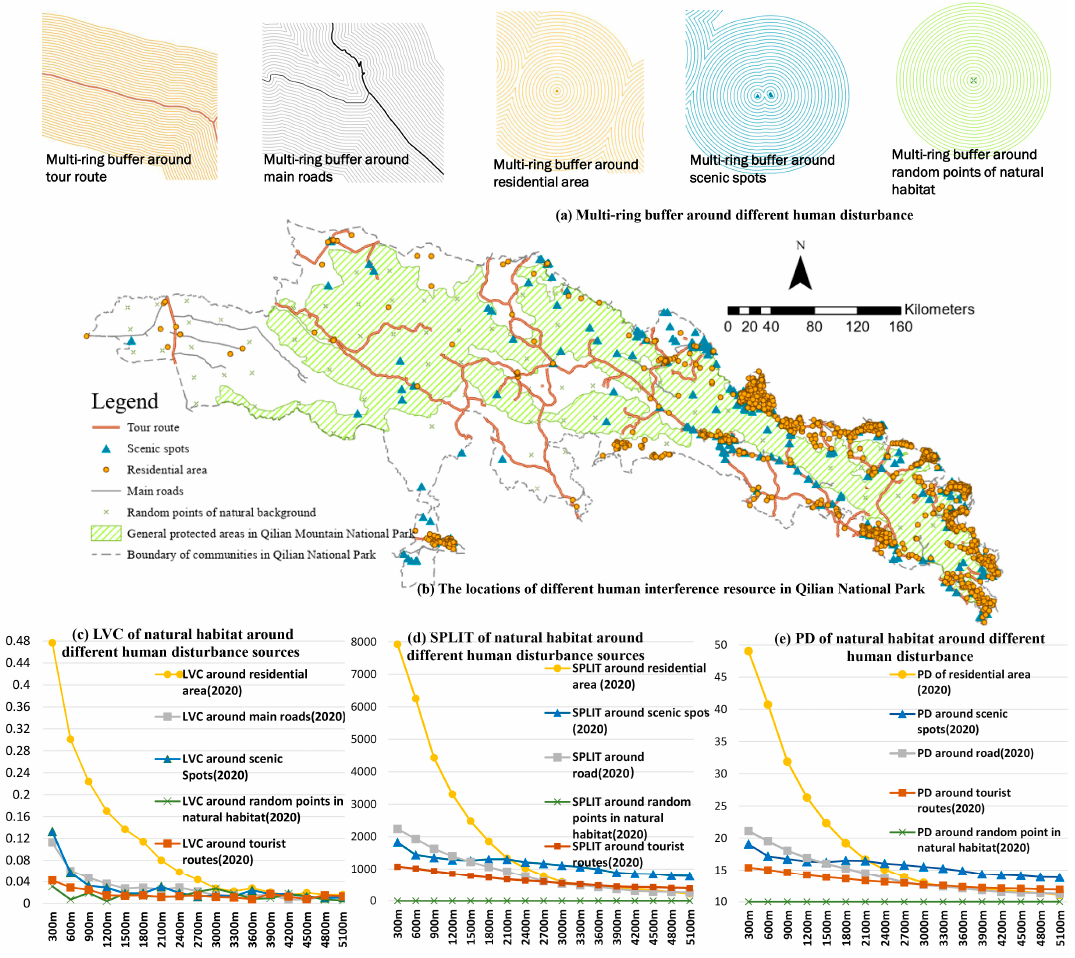
Figure 11. The results of landscape fragmentation analysis (LVC, PD, SPLIT) of the multi-ring buffer zones around different human resources.